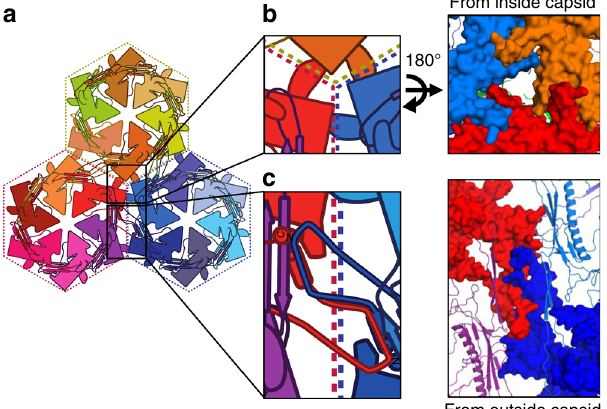
Fig. 7 Inter-capsomer stabilization by extended fl aps in P74-26 MCP. a Diagram of the threefold axis where three capsomers ( α -red, β -blue, and γ -yellow) meet. b The T-loop fl ap interacts with the P-domain of a neighboring subunit, forming a ring around the quasi-threefold/threefold axes. Right, tongue-in-groove interactions of T-loops and adjacent P-domains, as viewed from the capsid interior. c The N-arms of two adjacent subunits form interleaving fl aps where the N-arm binds to the S-loop of the neighboring subunit across the quasi-twofold/twofold MCP uses the T-loop to stabilize the interaction where three capsomers meet (i.e. the threefold and quasi-threefold axes) (Fig. 7a). (We de fi ne these capsomers as α , β , and γ for clarity.) The T-loop forms the inside surface of the capsid, where it binds the P-domain of an MCP in a neighboring capsomer in a tongue- in-groove fashion (Fig. 7b; Supplementary Fig. 7b). The interactions are reciprocated such that the T-loop of capsomer α binds the P-domain of capsomer β , and so on. Thus, the elbows form twofold fl aps on the capsid exterior to stabilize the twofold and quasi-twofold axes, while the T-loop forms tongue-in-groove interactions on the capsid interior to stabilize the threefold and quasi-threefold axes. The decoration protein forms an inter-capsomer cage . The Dec P74-26 trimer binds the capsid at the icosahedral threefold and